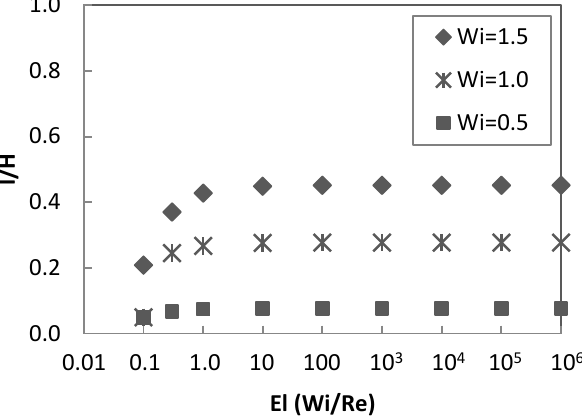
Figure 15. Non-dimensional elastic vortex length versus elasticity number for β = 0.1.